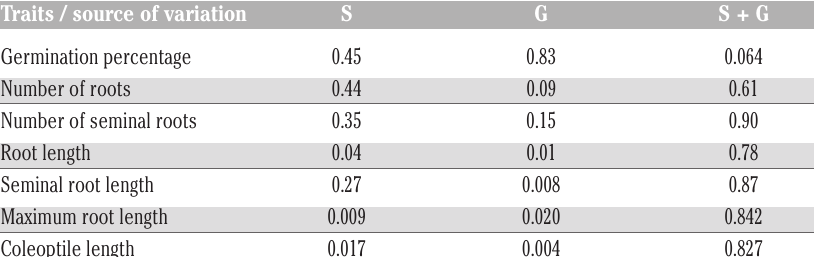
Table 4. Summary of the P values of two-way ANOVAs for the effects of salinity (S), geno- type (G), and their interaction (S + G) on the germination and root architectural traits of durum wheat